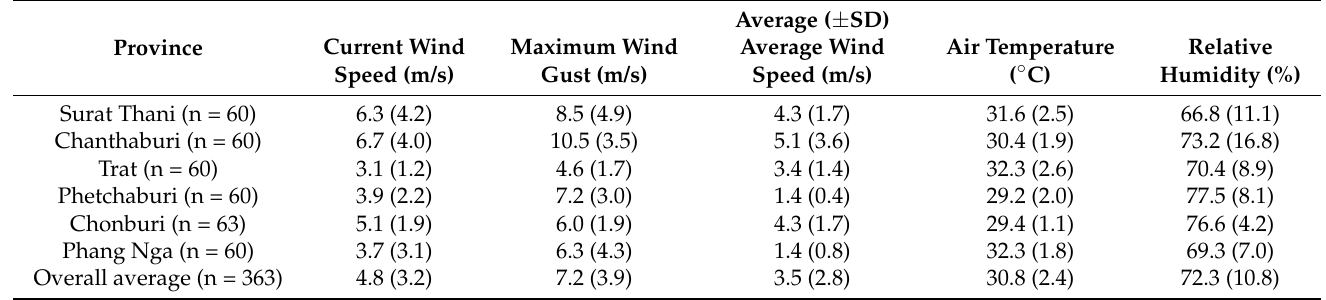
Table 1. Average and standard deviation of ambient air environmental parameters measured onsite at the time of sampling, stratified by province, from 2021–2022.